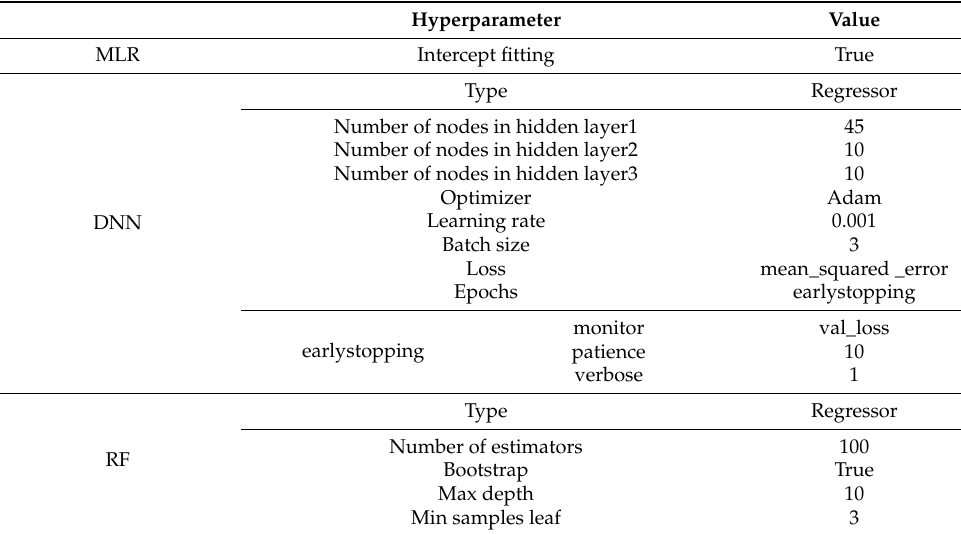
Table 5. Values of the hyperparameters set for DNN and